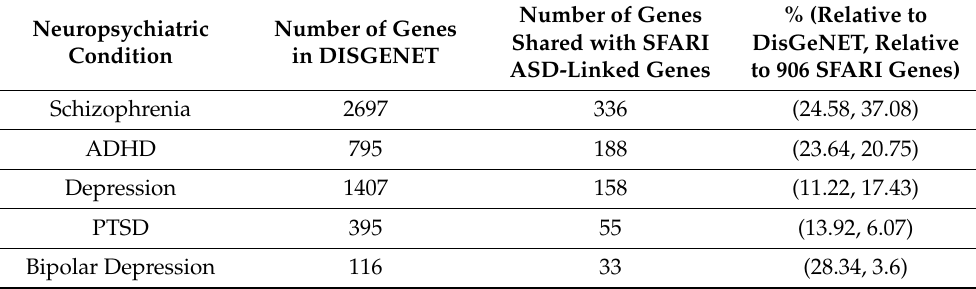
Table 1. Overlap between Autism-linked genes in SFARI and known neuropsychiatric disorders, ranked by the % of genes obtained relative to the number of genes in the SFARI set under considera- tion